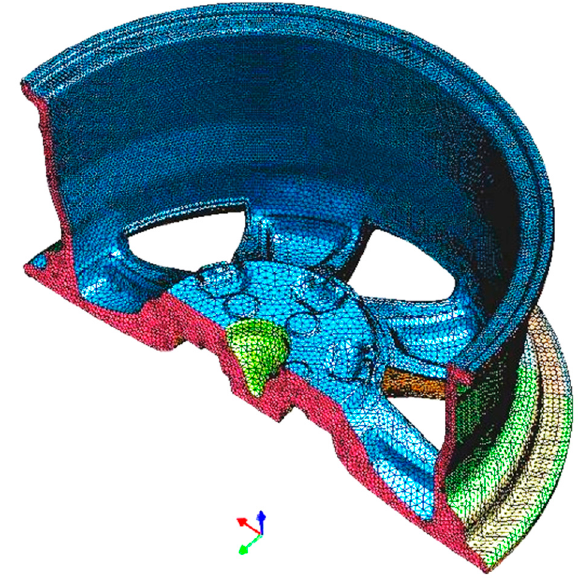
Figure 1. Mesh of the wheel produced with Die-A.